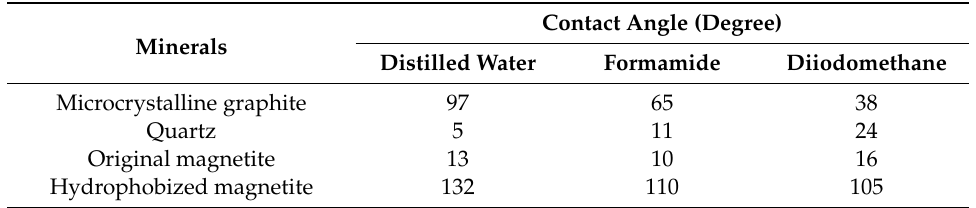
Table 1. Contact angle of microcrystalline graphite, quartz, and original and hydrophobized magnetite formed by a drop of water, formamide, and diiodomethane.